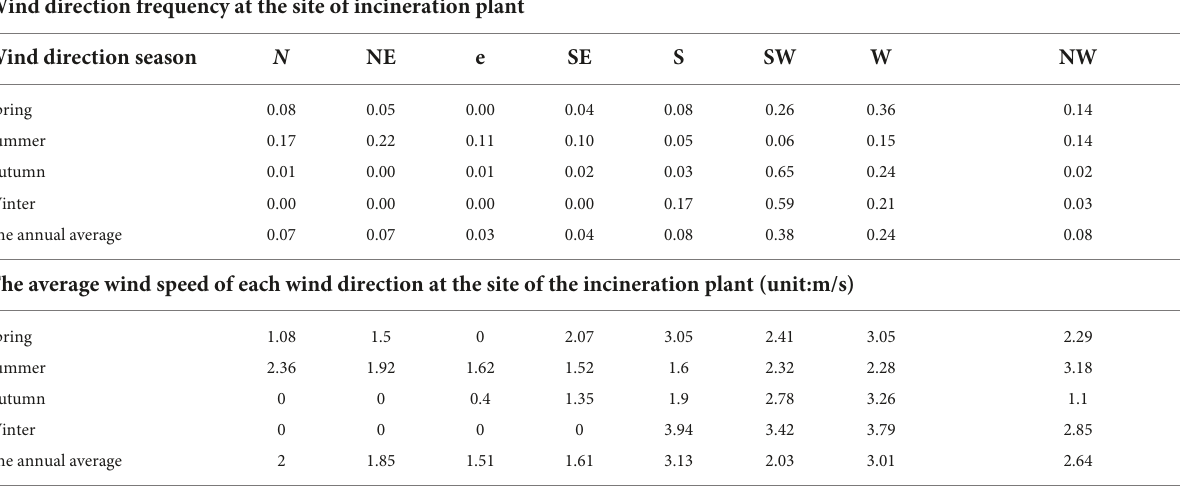
TABLE 2 EXCEL processing data results.